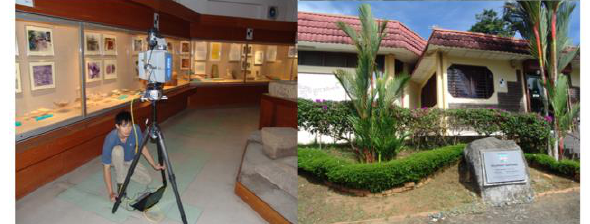
Figure 3. Scanning of Bujang Valley archaeological museum